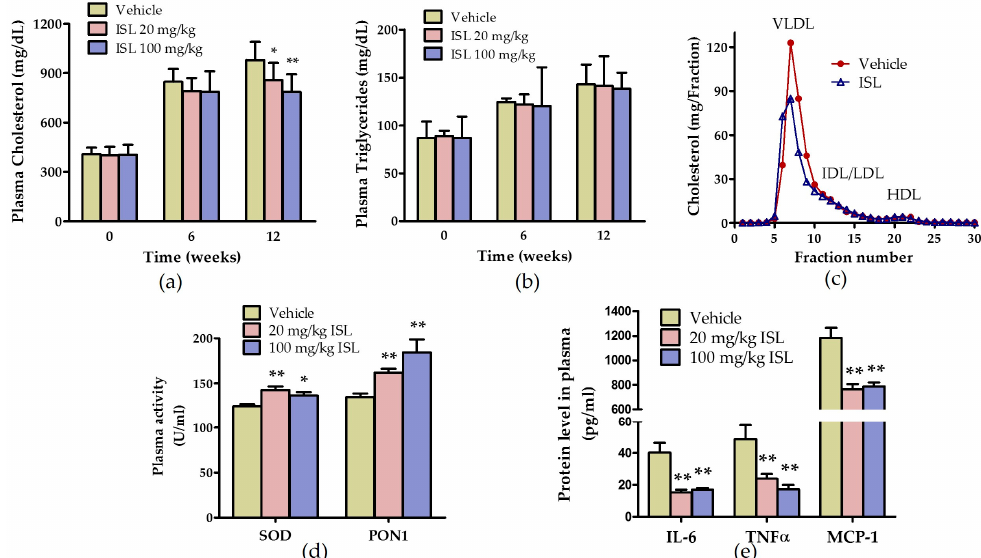
Figure 3. The effects of ISL on plasma lipids levels and antioxidative and anti-inflammatory status in apoE − / − mice fed a Western diet. Twenty-week old female apoE − / − mice were fed an AIN76A Western diet supplemented with 0.5% sodium carboxymethyl cellulose (CMC-Na) or ISL (20 mg/kg/day or 100 mg/kg/day) for 12-week, and then sacrificed. The plasma total cholesterol ( a ) and triglyceride ( b ) levels were measured at the indicated time as described in the Methods section ( n = 8–10; * p < 0.05, ** p < 0.01 vs. vehicle group at the same time point); ( c ) plasma lipoprotein profiles in apoE − / − mice with or without high-dose ISL (100 mg/kg/day) supplementation. Lipoproteins in pooled plasma were size-fractionated by fast protein liquid chromatography (FPLC), and the cholesterol contents within lipoprotein fractions (very low-density lipoprotein (VLDL), LDL, and high-density lipoprotein (HDL)) were measured; ( d ) the plasma superoxide dismutase (SOD) and paraoxonase-1 (PON1) activities of apoE − / − mice were measured at the endpoint using an enzymatic colorimetric assay ( n = 8–10; * p < 0.05, ** p < 0.01 vs. vehicle group); ( e ) plasma IL-6, TNF- α , and MCP-1 levels were determined using enzyme-linked immunosorbent assay (ELISA) ( n = 5–7; ** p < 0.01 vs. vehicle